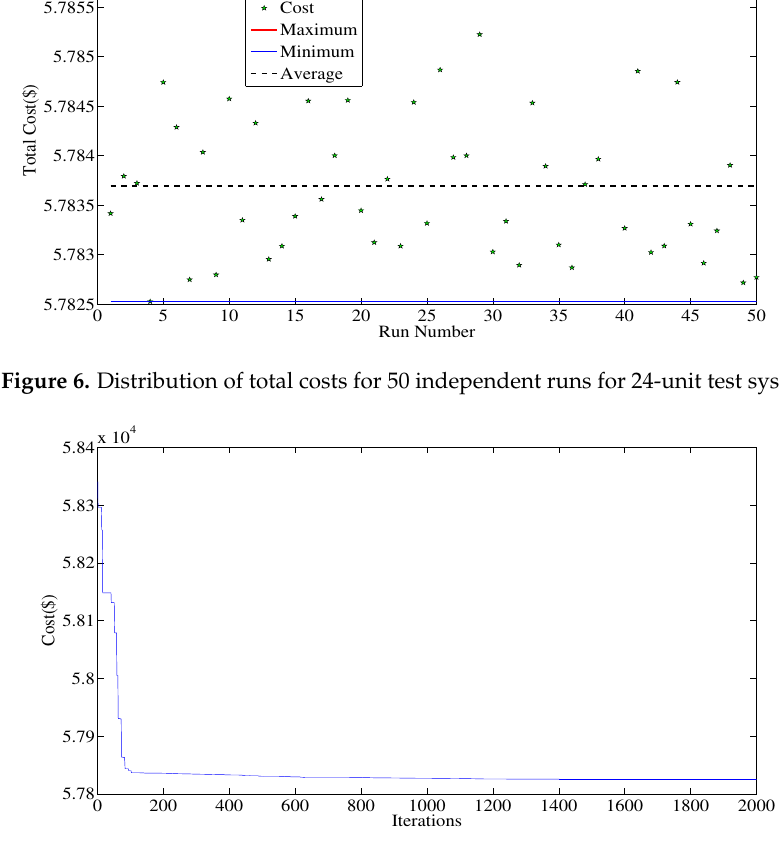
Figure 7. Convergence characteristics of the proposed IABC algorithm for 24-unit test